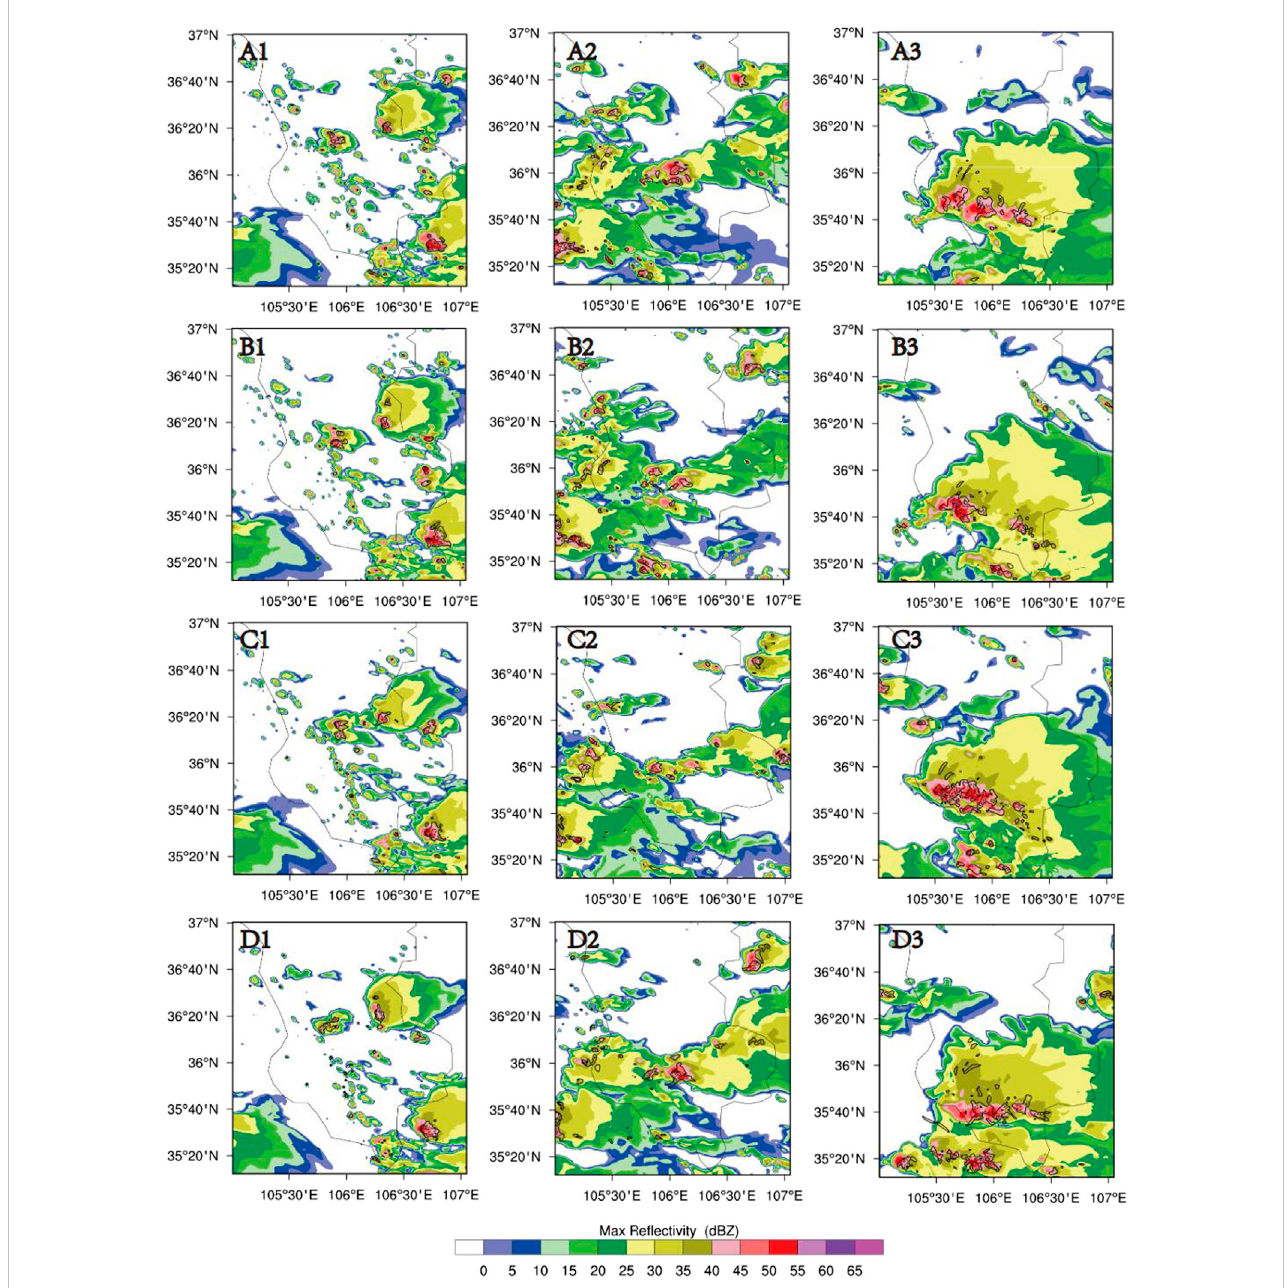
Composite radar re fl ectivity (Unit: dBZ) simulated with TH-AU scheme, with the solid line as the area where the updraft is greater than 5 m/s: (A) NCCN 50 (B) NCCN 200 (C) NCCN 2000 (D) NCCN 10000; (1) 0600 (2) 0800 (3) 1000